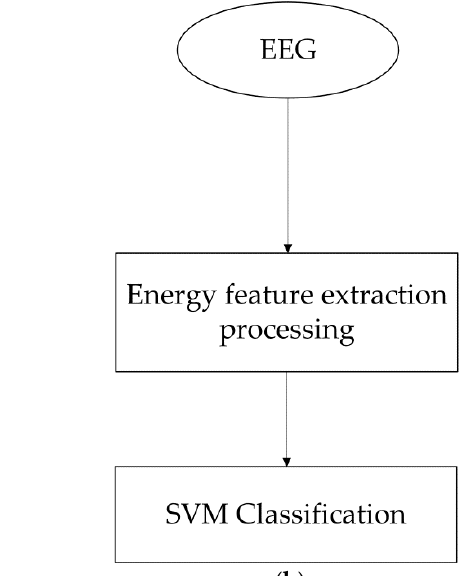
Figure 5. Implementation of Method 1( a ) and Method 2( b ).